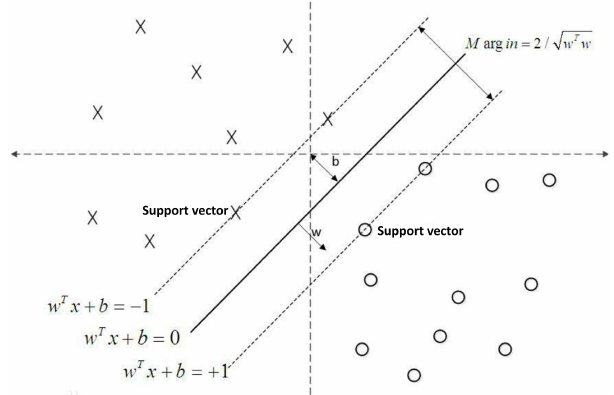
Figure 6. The decision boundary of support vector machine with the largest margin. × and o denote two-class training examples. w T x + b = 0 is the optimal hyperplane to do the separation, where w is a weight vector and b is a bias, and an SVM training model √ w T w is built. The support vectors are with the largest margin 2 / the samples on the dotted lines. The optimization classification hy- perplane is determined by the solid line.